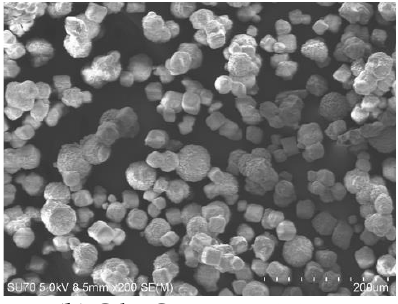
Figure 9. Removal ratio of Pb 2+ without Ca 2+.